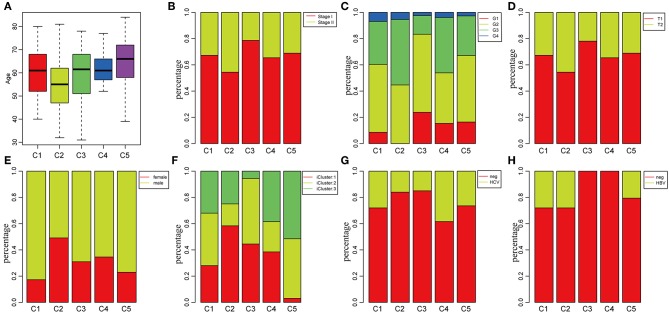
Factor analysis of five HCC subtypes based on clinical characteristics. (A) Age distribution in the five HCC subtypes. (B) Stage ratio distribution in the five HCC subtypes. (C) Histological grade ratio distribution in the five HCC subtypes. (D) T stage ratio distribution in the five HCC subtypes. (E) Gender ratio distribution in the five HCC subtypes. (F) Distribution of subtypes underlying global classification in five subtypes. (G) Hepatitis C virus (HCV) distribution in the five HCC subtypes. (H) Hepatitis B virus (HBV) distribution in the five HCC subtypes.